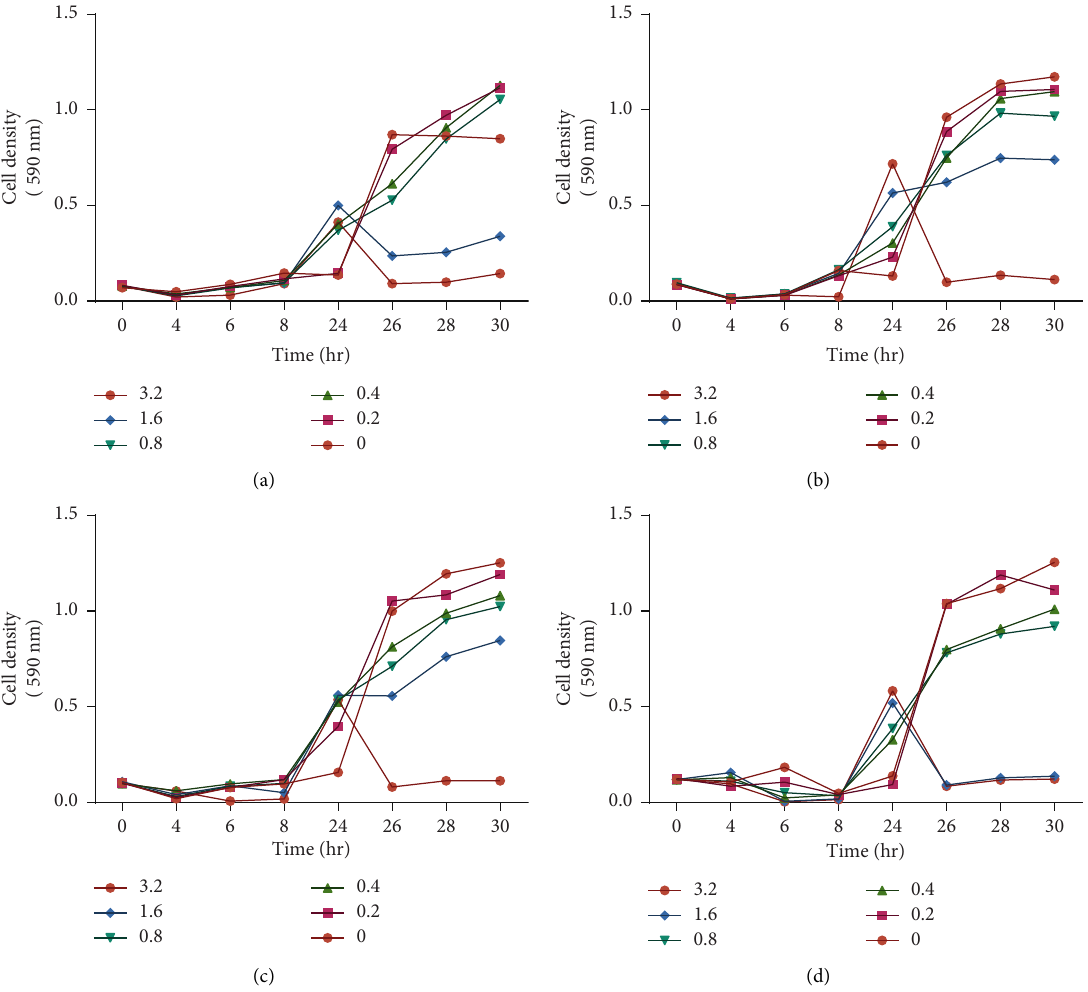
Figure 3: The effects of combining tormentic acid congener and ciprofloxacin on P aeruginosa . The effect of ciprofloxacin on P aeruginosa together with a concentration of (a) 0 µ g/ml, (b) 25 µ g/ml, (c) 50 µ g/ml, and (d) 100 µ g/ml of tormentic acid